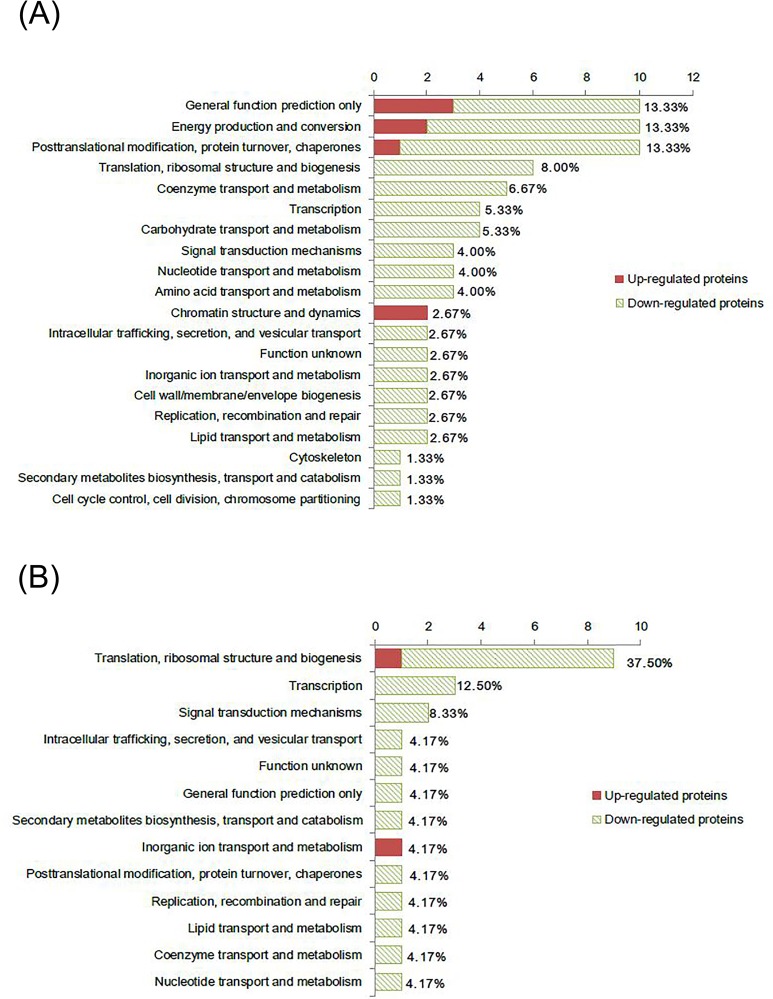
Functional category (COG) coverage of the significantly regulated proteins identified in T. pseudonana under N-limited (A) and P-limited (B) conditions based on iTRAQ-LC-MS/MS analysis. One protein may be assigned to more than one functional category. Significantly regulated proteins without COG description (58 and 35 proteins in N- and P-limited cells, respectively) are not shown.